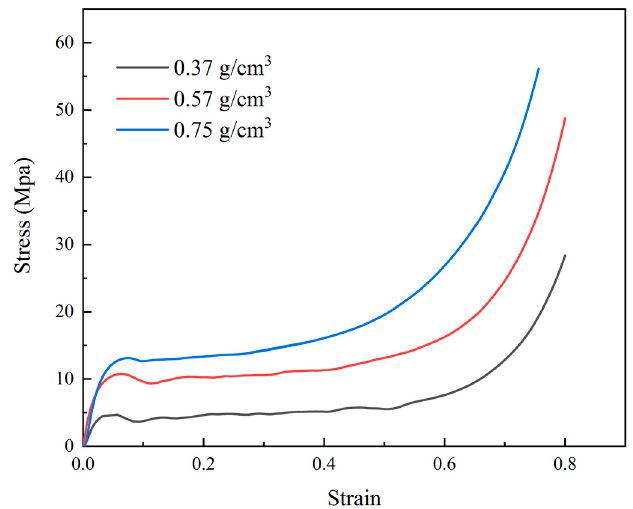
Figure 2. Compressive stress–strain curves of aluminum foams.